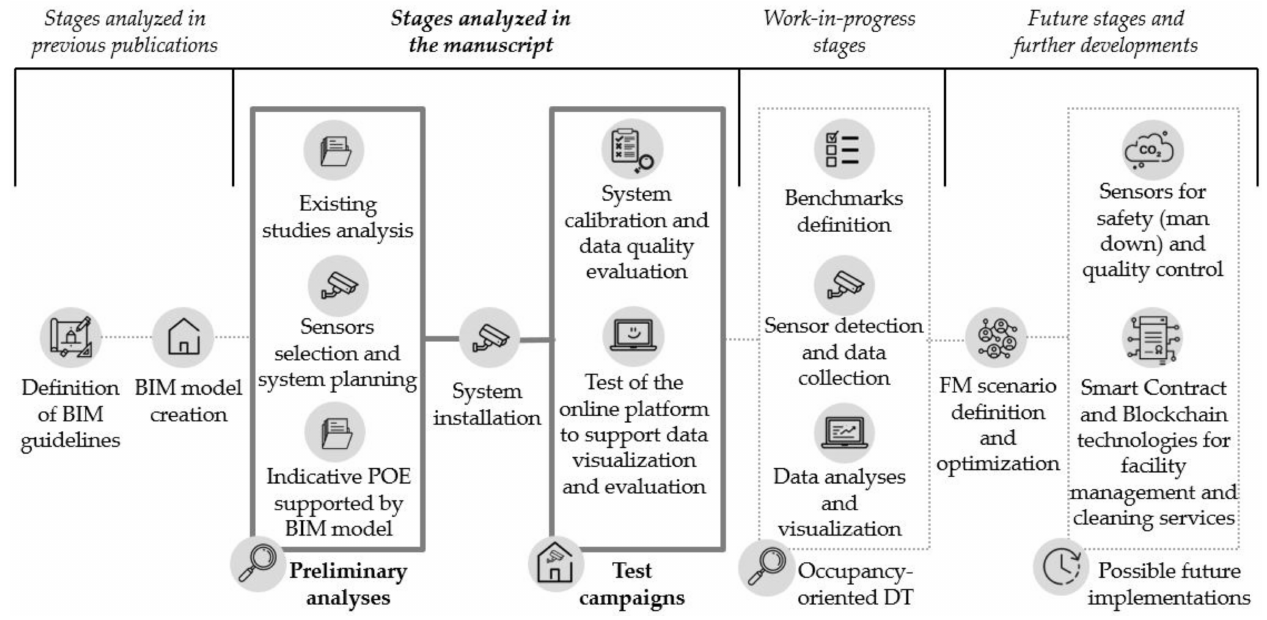
Figure 1. Stages of the research